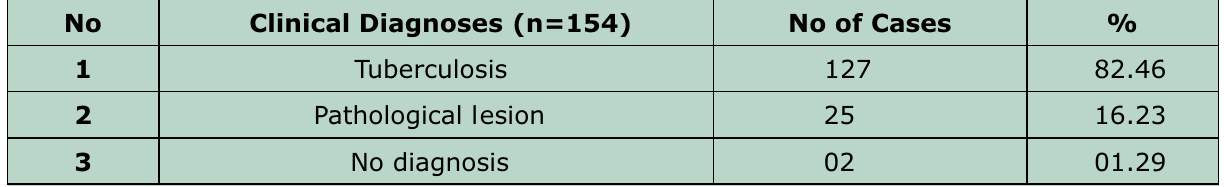
Table-II: Clinical diagnoses in histopathologically proven tuberculous spine biopsies: No